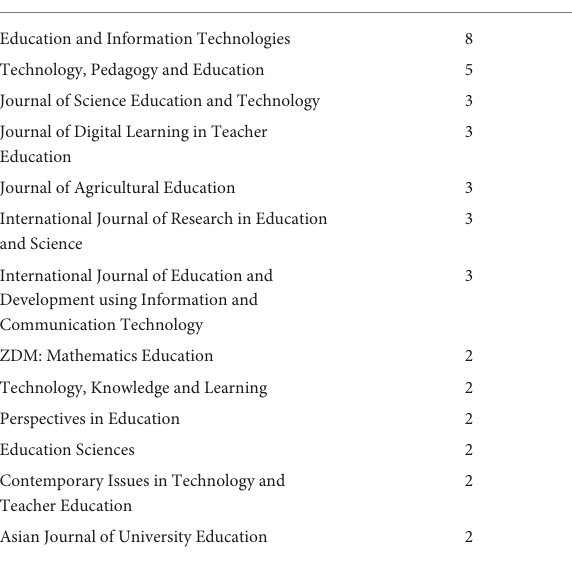
TABLE 2 Number of articles in the systematic literature review (SLR) by